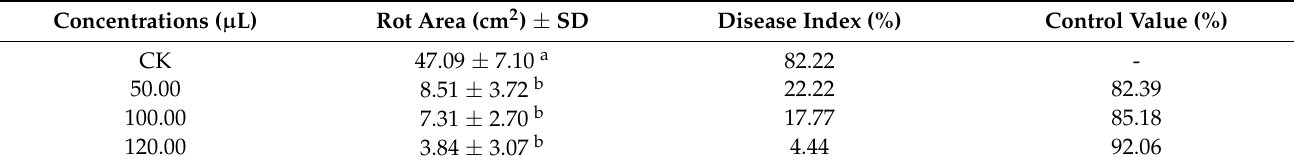
Table 4. Inhibitory effects of A.scoparia essential oil against C. gloeosporioides on natural morbidity.